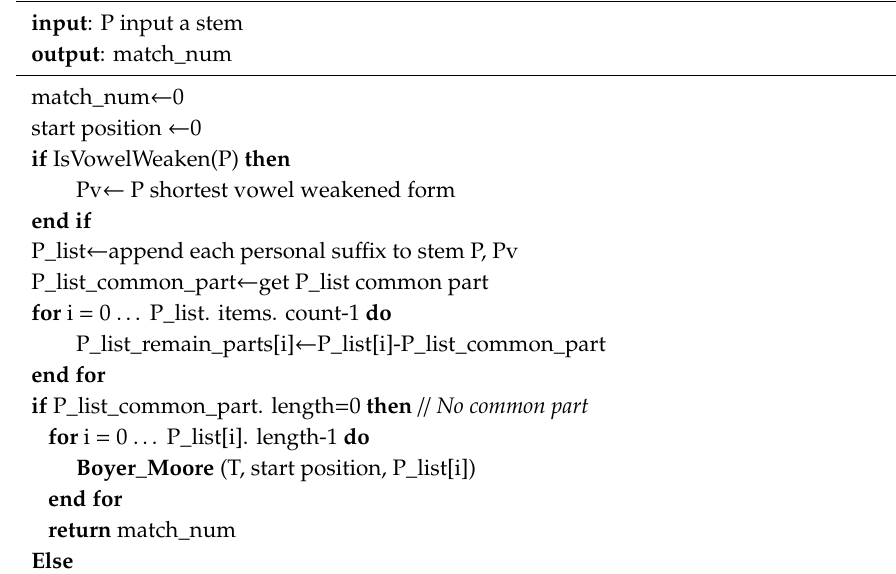
Algorithm 1. BM-U (P, T) pattern matching